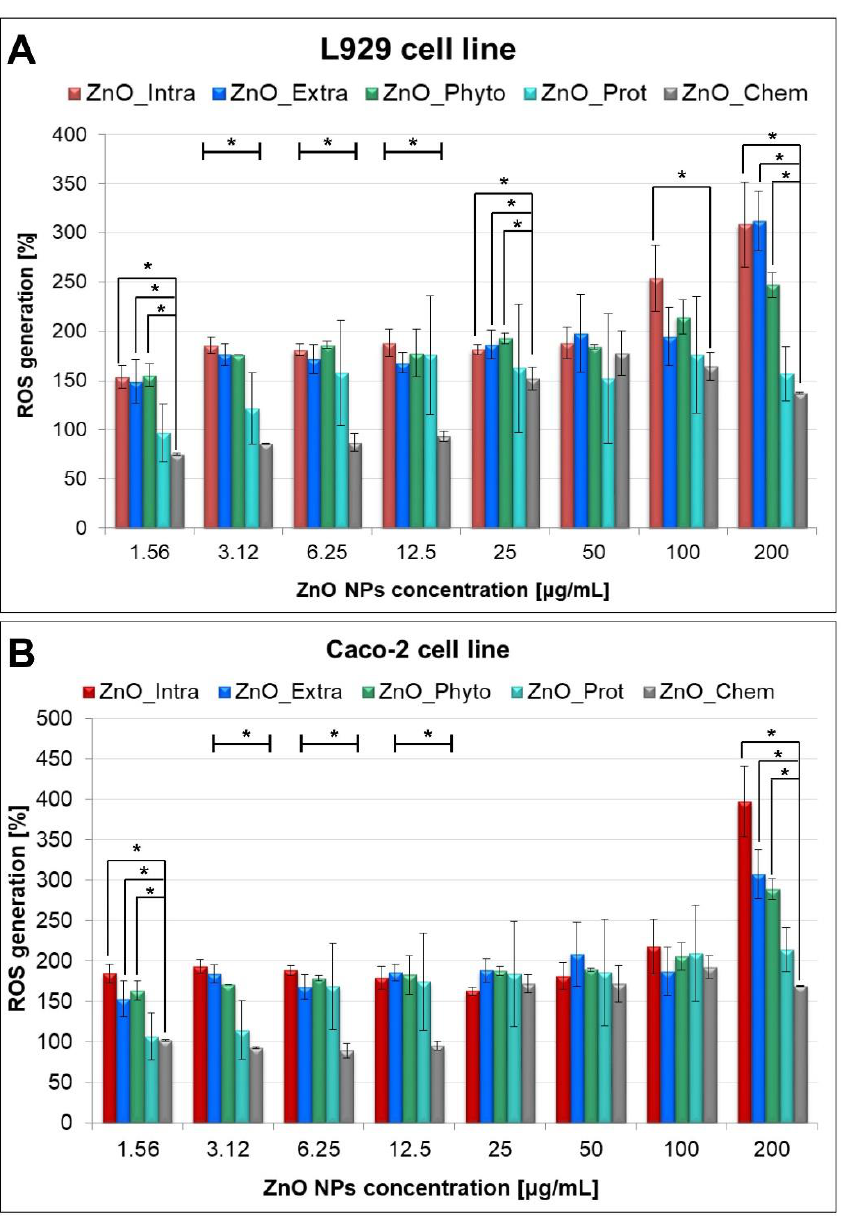
Figure 6. Concentration-dependent ROS generation by bare and functionalized ZnO-NPs in ( A ) L929 and ( B ) Caco-2 cells. The values are expressed as mean ± SD values of three independent experiments ( n = 3); * p < 0.001 compared to bare ZnO NPs (ANOVA).